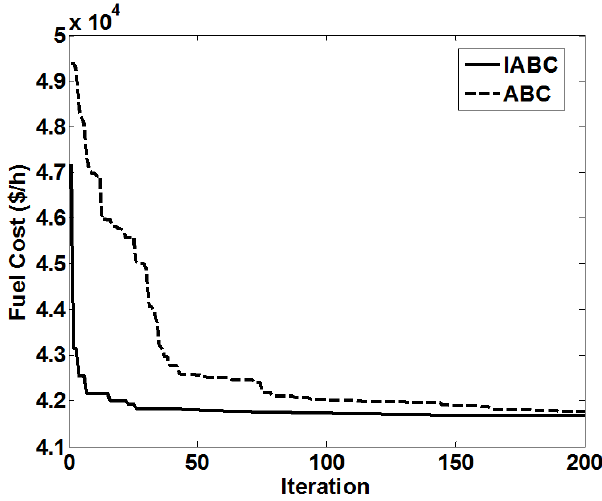
Figure 12. Convergence characteristics of fuel cost of the IABC and ABC algorithms for the IEEE 57-bus